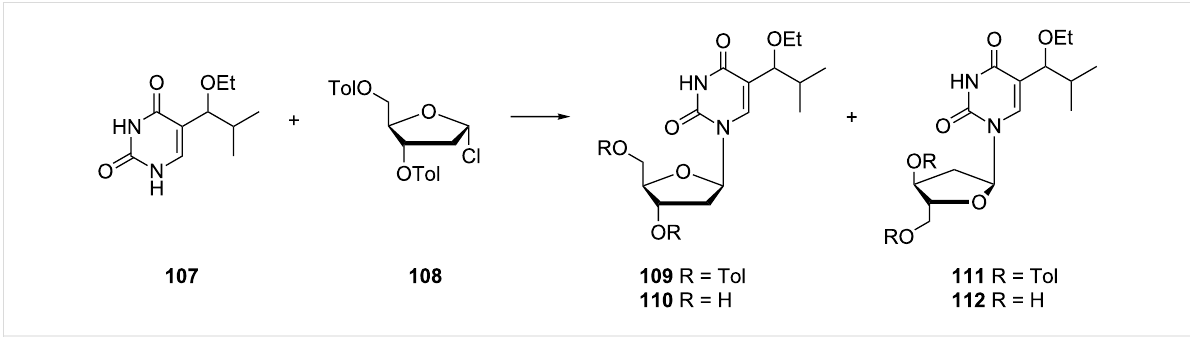
Scheme 18: Synthesis of β - and α -anomer of 5-(1-ethoxy-2-methylprop-1-yl)-2'-deoxyuridine.